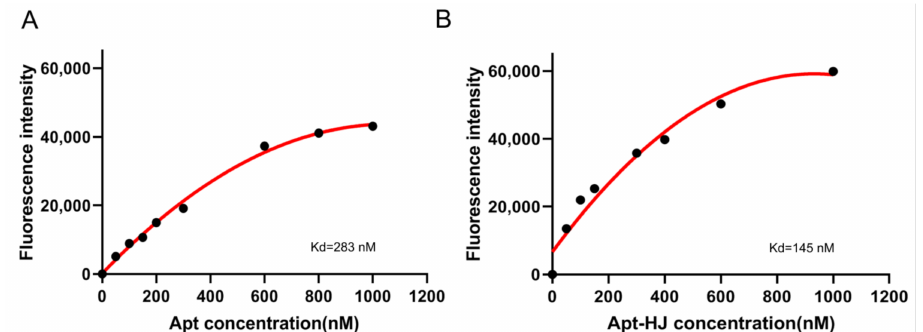
Figure 6. Estimation of apparent binding affinity to CT26 cells by free PD-L1 Apt ( A ) or Apt-HJ ( B ). CT26 cells were incubated with FAM-labeled PD-L1 aptamers or Apt-HJ of various concentrations for 30 min, washed thrice in PBS, and analyzed by flow cytometry. Duplicate samples ( n = 2) were used for each concentration in the experiment. The mean of the two fluorescence measurements was used in the chart.